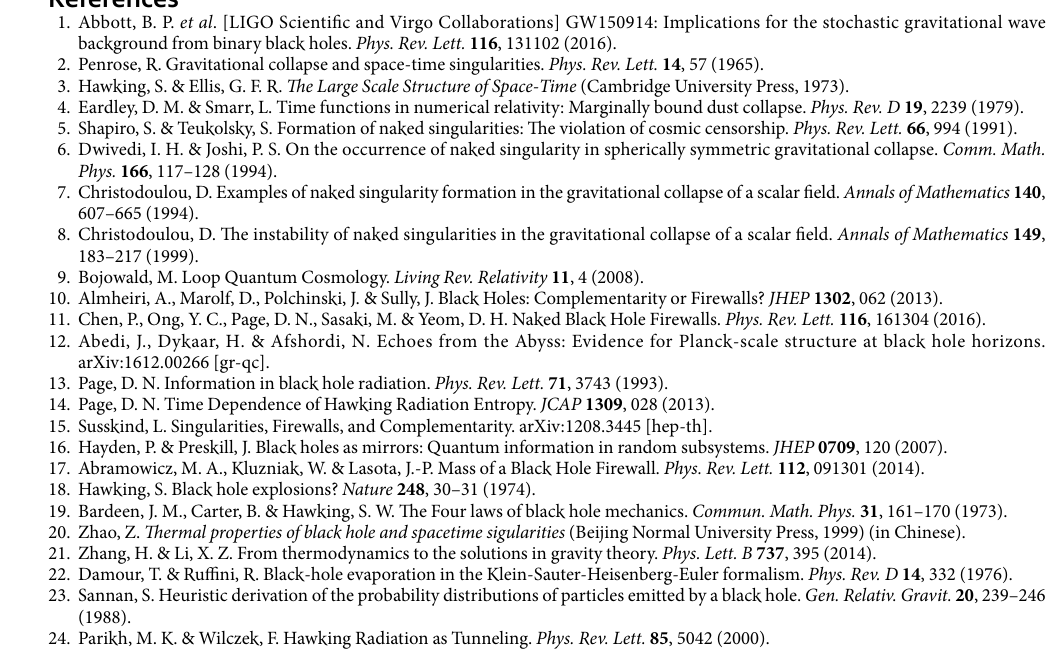
In all theories, it is a marvel that general relativity can predict where it fails by itself. This is the singularity. We demonstrate the properties of the Hawking evaporation of the spacetimes with naked singularities. The Hawking photons evolve unitarily when crossing the singularity. This result indicates that a firewall may not lead to a non-unitary evolution of the Hawking photons. The thermodynamics of a naked singularity is far from com- plete. Now we just have some preliminary results by the aids of the AdS/CFT correspondence 27, 28 . Especially, the Gibbons-Maeda-Garfinkle-Horowitz-Strominger (GMGHS) dilaton black hole has a null singularity at the extremal limit 29, 30 , which is similar to a firewall singularity at the horizon. The temperature of the extremal GMGHS black hole is κ /(2 π ) 31 , which coincides with our result directly derived from the Hawking radiation. Our study sheds some light on the quantum effects for naked singularities and lays a general foundation for a sound thermodynamics for spacetimes with naked singularities. Einstein and Rosen thought that the horizon of the Schwarzschild is a true singularity, and thus should be removed from realistic spacetimes 32 . It is believed that a singularity will ruin all physical laws around it. Now we show that the theory may be tractable even when there is a true singularity at the horizon.